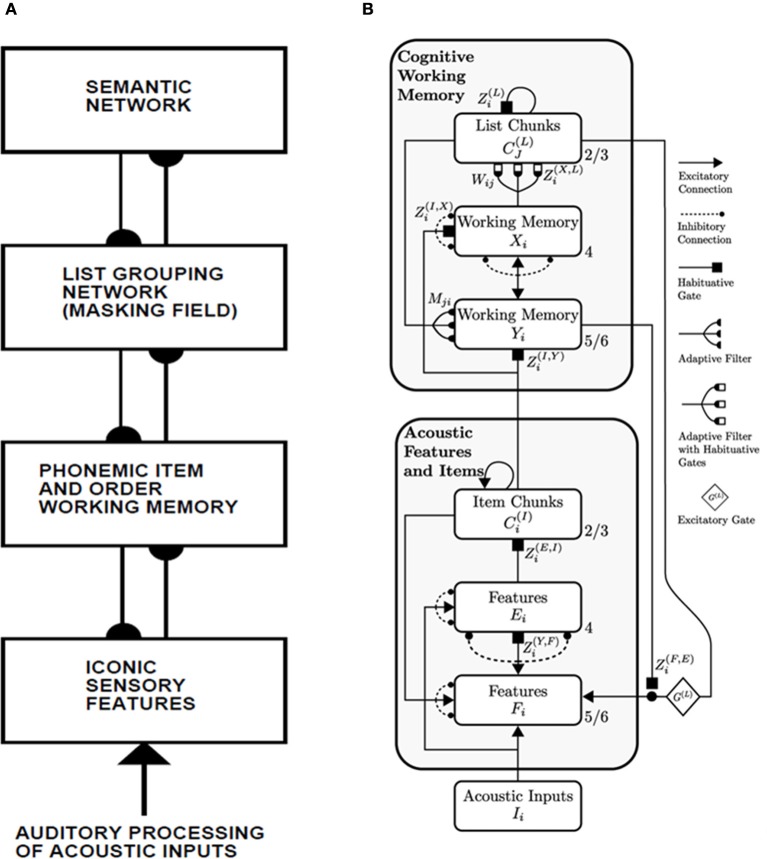
(A) ARTWORD processing levels for speech perception. (Reprinted with permission from Grossberg and Myers, 2000). (B) cARTWORD laminar cortical model for conscious speech perception. (Reprinted with permission from Grossberg and Kazerounian, 2011).